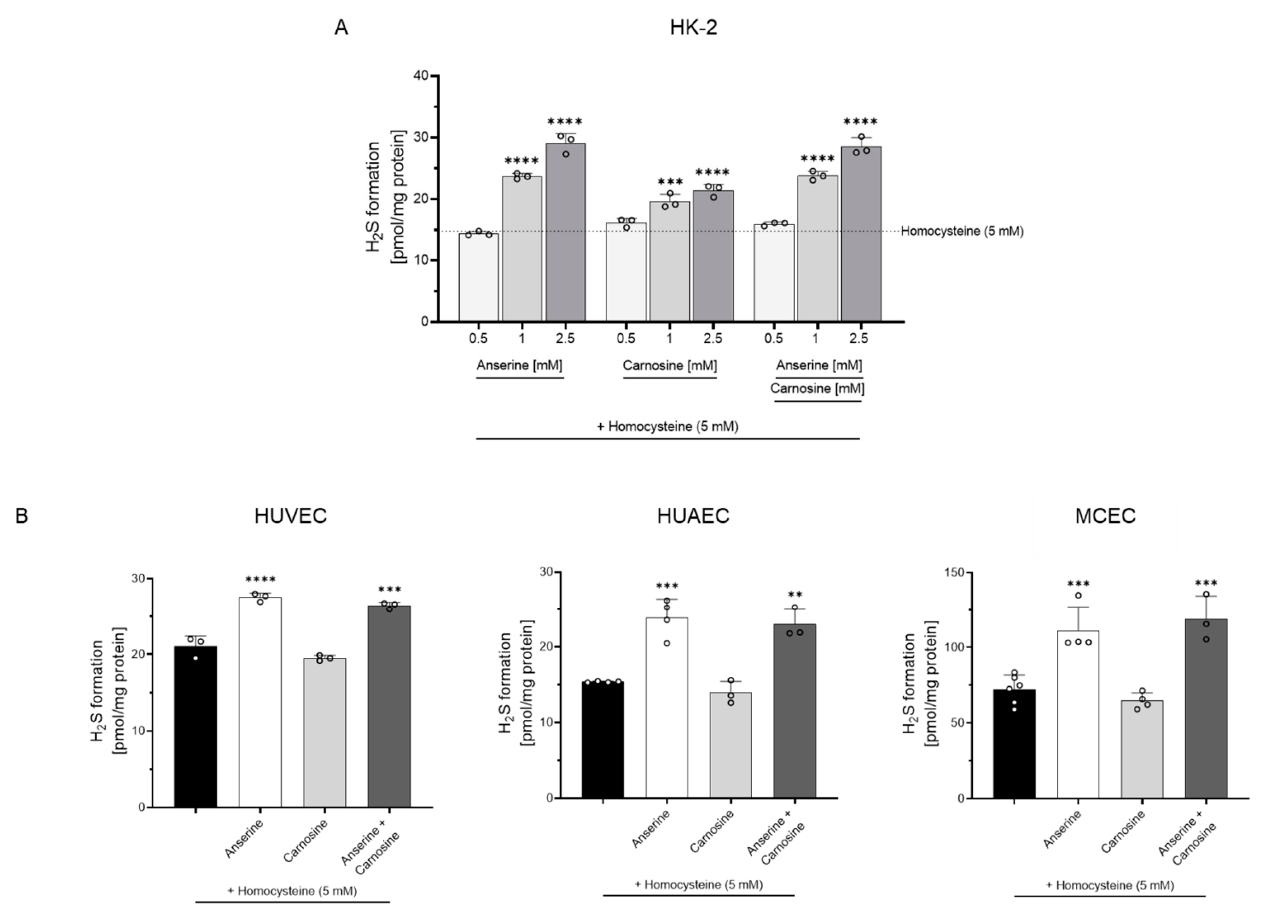
Figure 1. H 2 S formation in proximal tubular epithelial (HK-2) and endothelial cells (HUVEC, HUAEC, MCEC). ( A ) Anserine and carnosine dose-dependently increased H 2 S formation in HK-2 cells. ( B ) Treatment of HUVEC, HUAEC and MCEC with anserine but not carnosine (each 1 mM) increased H 2 S formation compared to untreated cells. **: p < 0.01; ***: p < 0.001; ****: p < 0.0001 (one-way ANOVA with Tukey’s test).